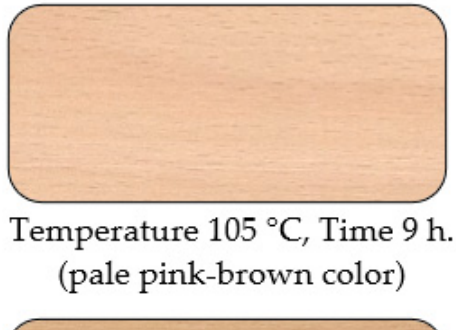
Figure 2. Mode of color modification of beech wood by steaming with a saturated mixture of steam and air or saturated water steam. Note: Reproduces from Dzurenda, L. Colouring of beech wood during thermal treatment using saturated water steams; published by Acta Fac. Xylologiae Zvolen, 2014, with permission from Acta Fac. Xylologiae Zvolen, 2022.